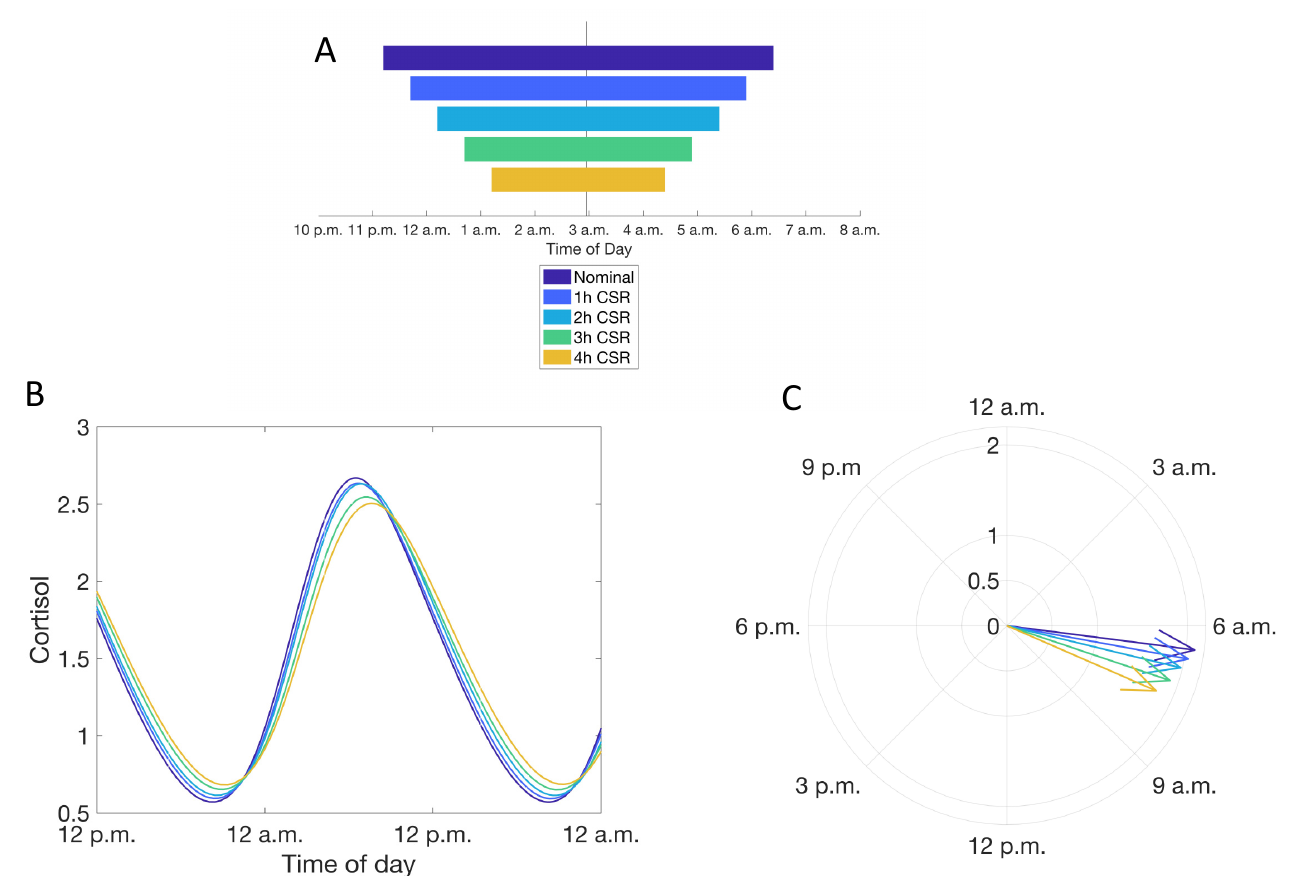
(black shaded bars at top of panels) and light-dark (white and grey shaded regions, respectively) schedules.